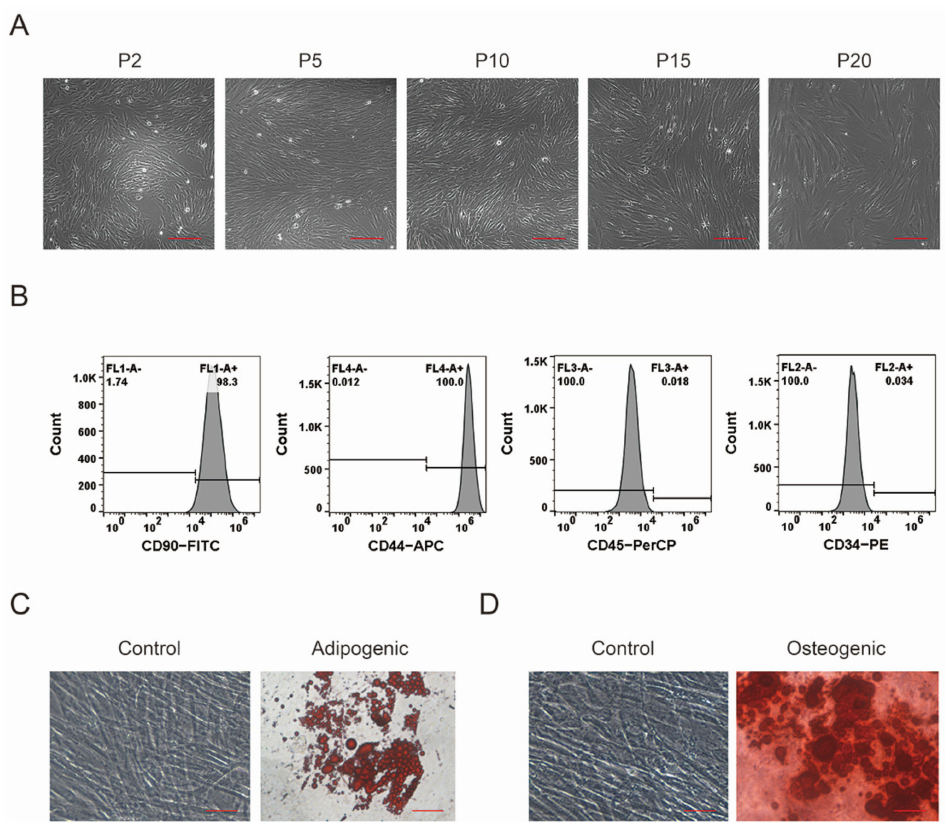
Figure 1. Isolation, culture, and identification of pMSCs. ( A ) Representative images of porcine MSCs at P2, P5, P10, P15, and P20. Scale bar = 200 µ m. ( B ) Immunophenotypic analysis of pMSCs at P3 using flow cytometry. ( C ) Identification of adipogenic differentiation using oil red O staining. ( D ) Identification of osteogenic differentiation using alizarin red staining. Scale bar = 10 µ